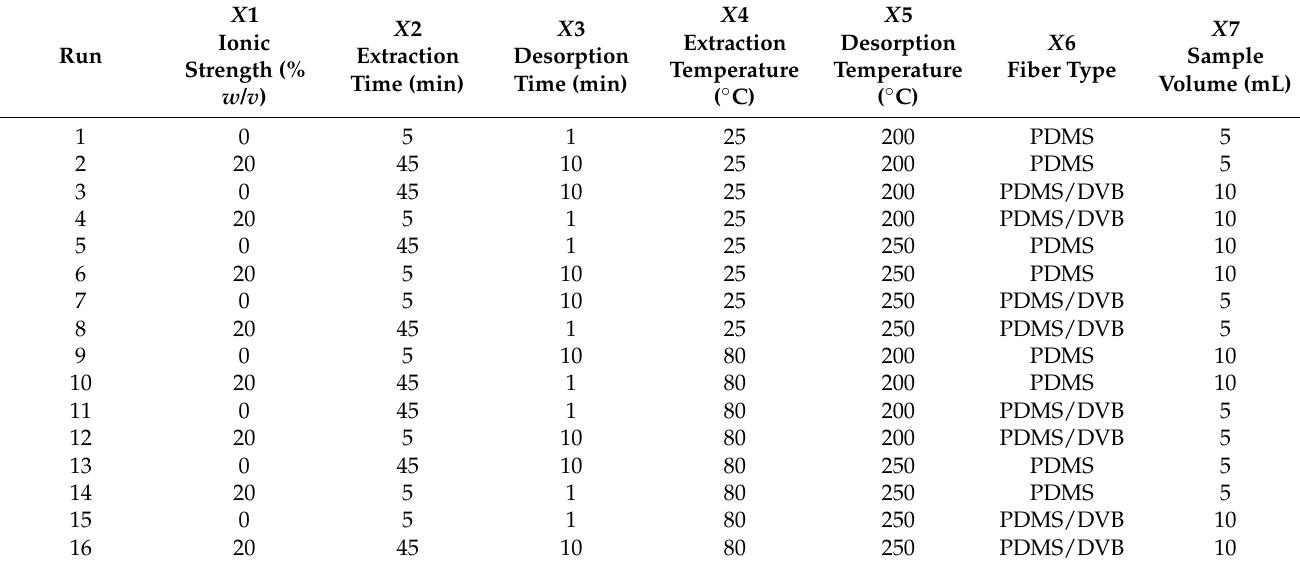
Table 2. Proposed screening